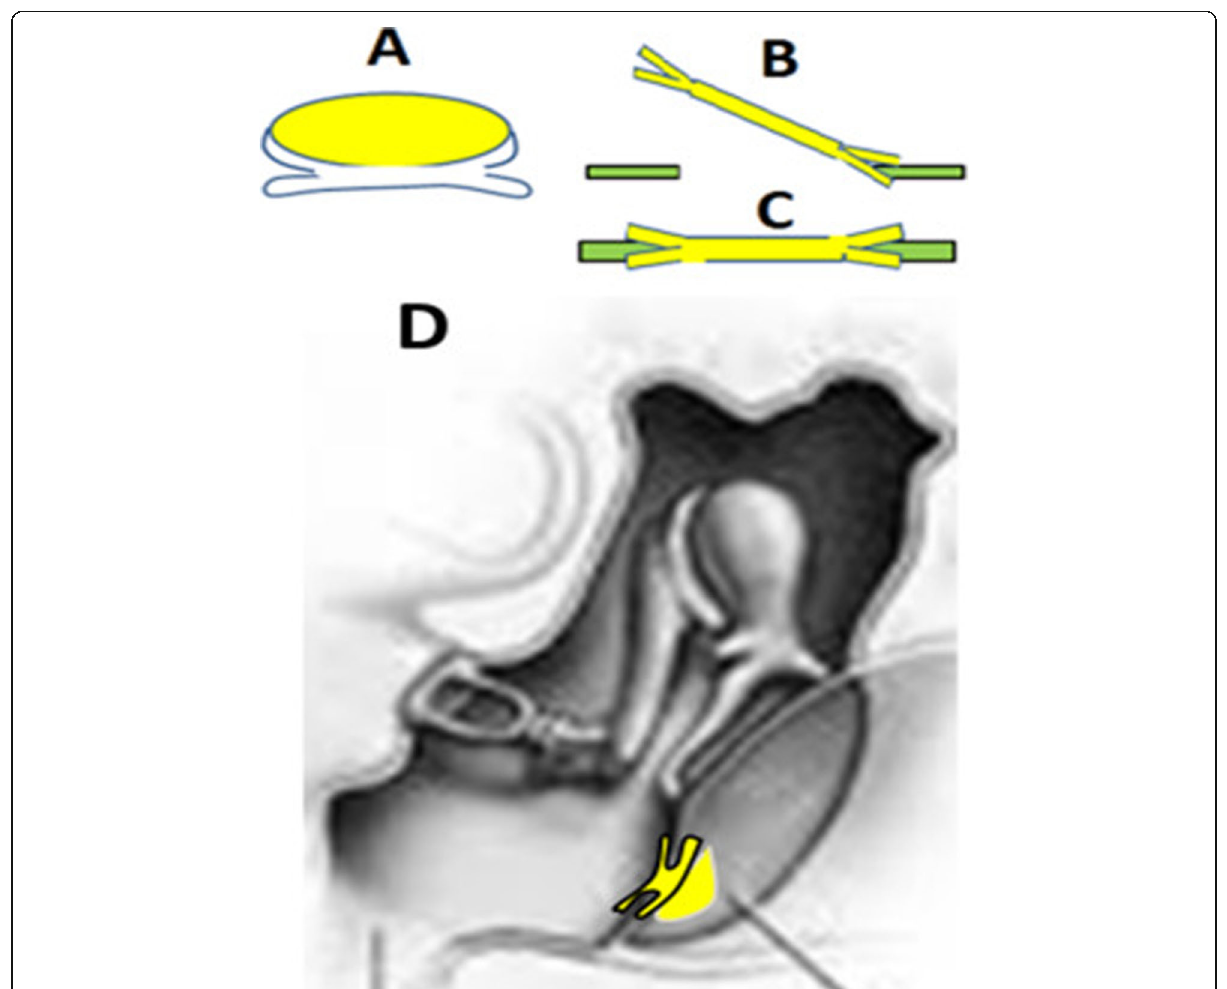
Fig. 2 The inlay butterfly cartilage